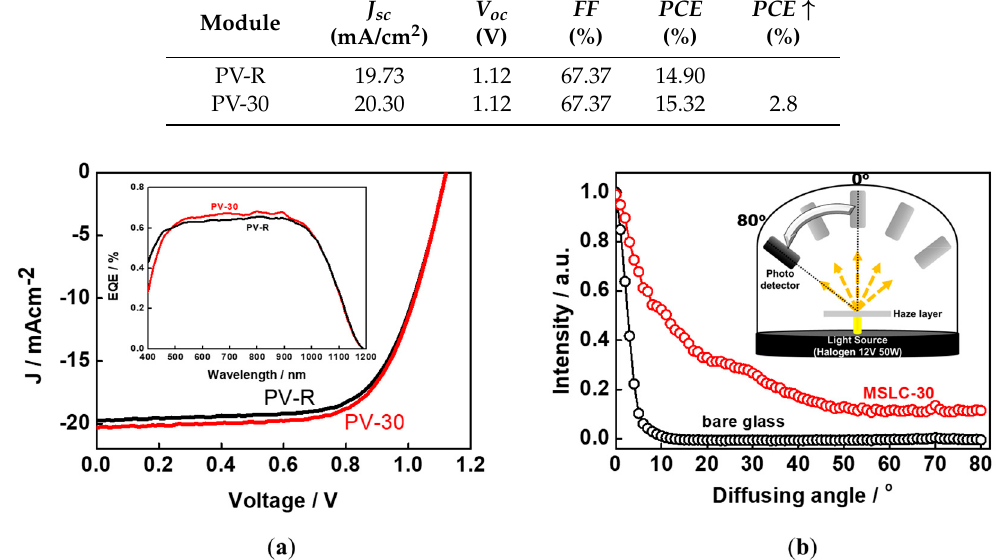
Figure 7. ( a ) Current-voltage (J–V) curves of PV-R and PV-30. External quantum efficiency (EQE) curves of the two modules are also presented in the inset. ( b ) Bidirectional transmittance distribution function (BTDF) of transmitted light through MSLC-30 and bare glass. A schematic diagram of the measurement set-up for BTDF is also provided in the inset. Light that was vertically incident on the film was used as the incident beam.